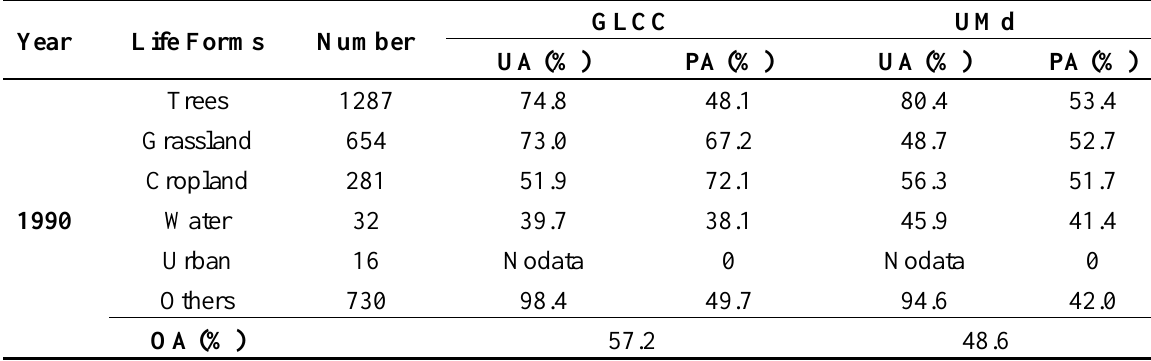
Table 2. Summary of error matrixes for GLCC (Global Land Cover Characterization), UMd (University of Maryland land cover product) in China.